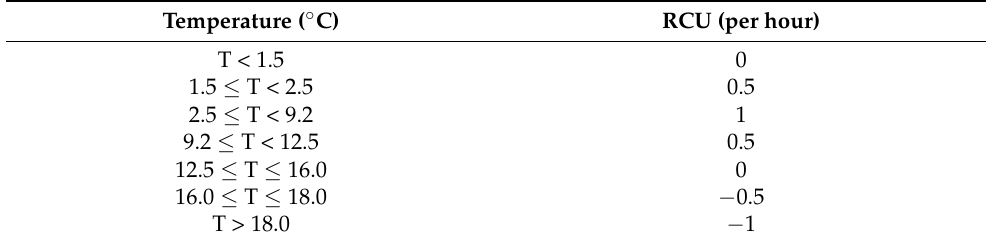
Table 4. Calculation of chill units from hourly temperature data applying the Utah Model